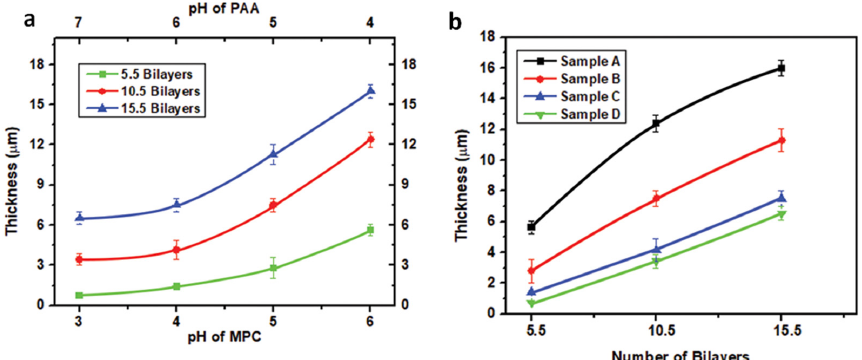
Figure 8. Thickness of the prepared thin film gradients. ( a ) Effect of the combinations of pH of MPC/PAA and ( b ) Effect of the number of bilayers.